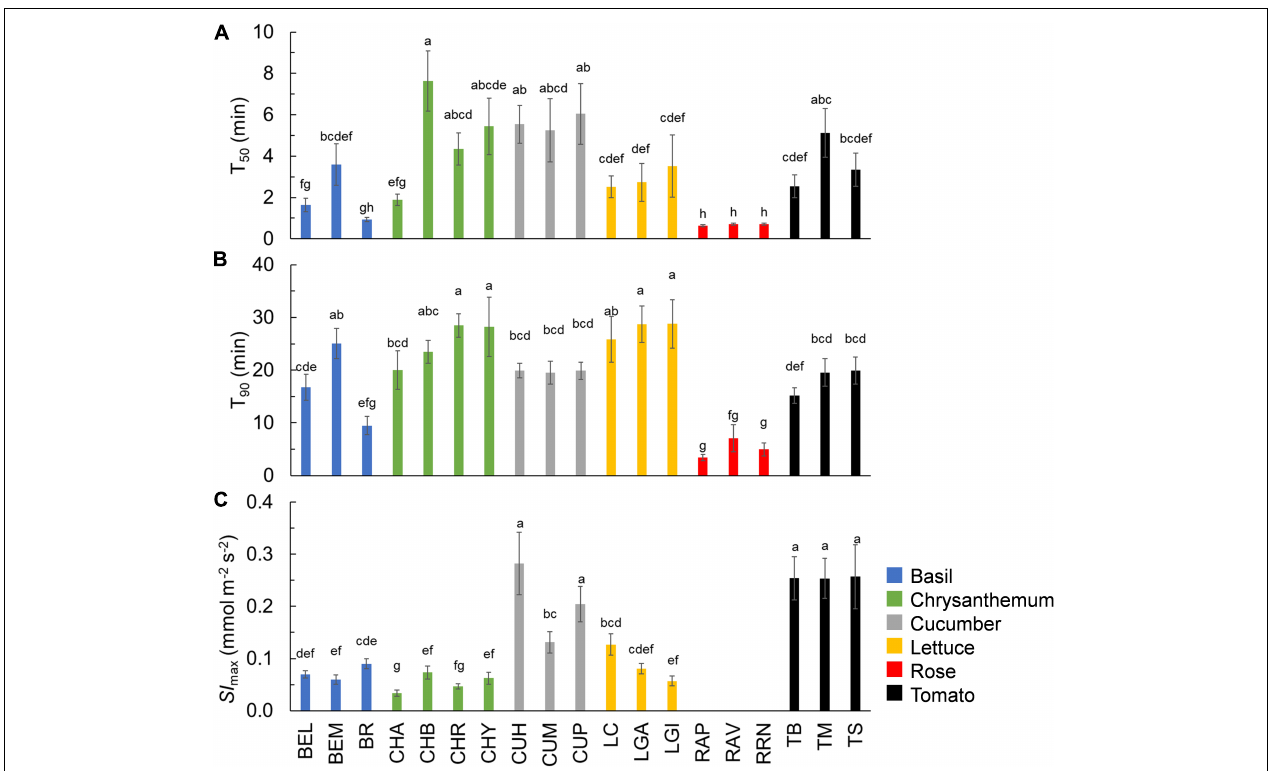
FIGURE 2 | Time needed for A to reach 50% ( A: T 50 ) and 90% ( B: T 90 ) of full photosynthetic induction, as well as the maximum rate of stomatal opening after an increase in irradiance ( C: Sl max ) in 19 horticultural genotypes. Colors indicate crop species. Bars show means ± SE ( n = 7–9). Letters indicate significant differences ( p < 0.05). For T 50 , the result of the statistical test was based on log transformation of original data. Sl max was not estimated for rose. Refer to Table 1 for full genotype